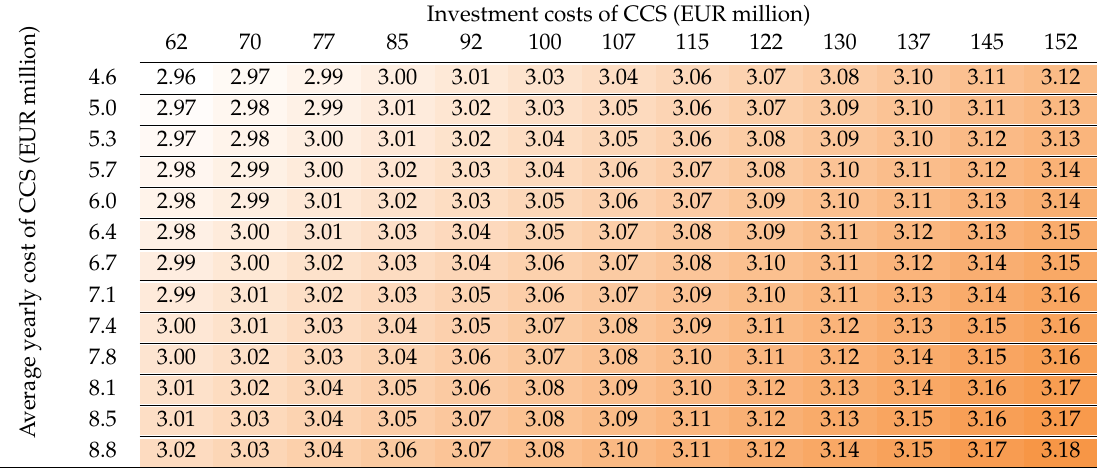
Table 13. LCOH 2 for hard coal gasification with CCS system (per 1000